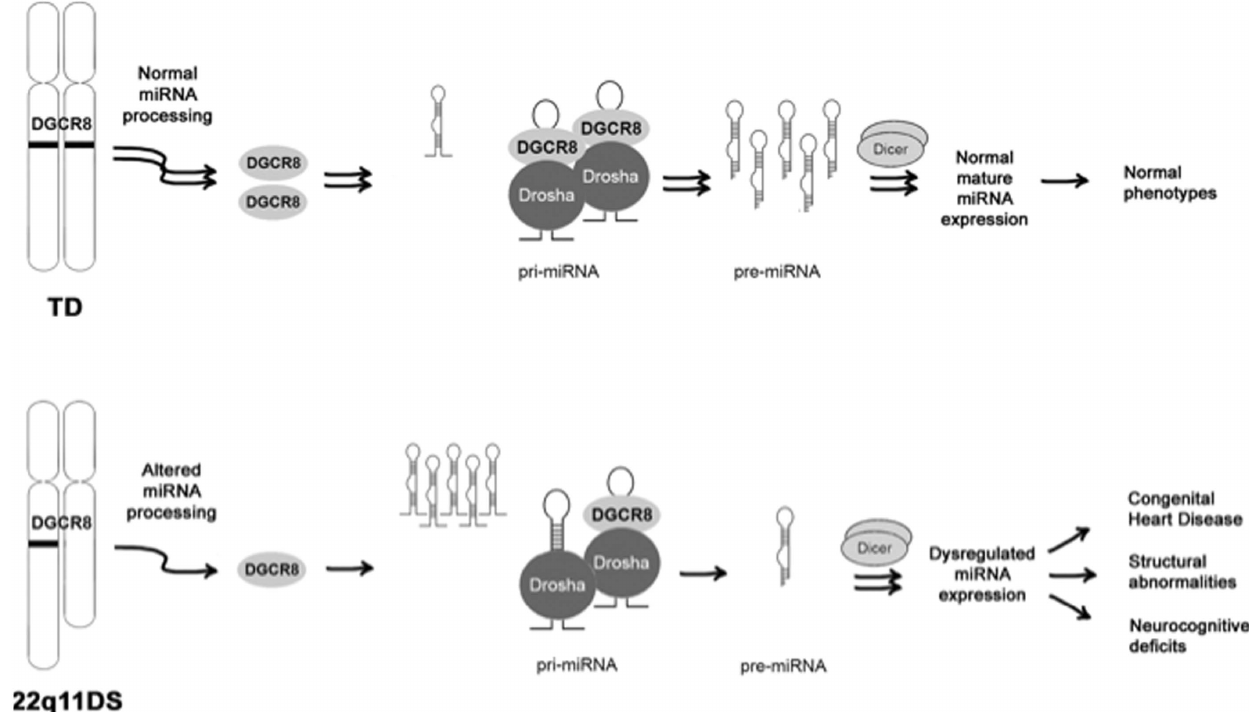
Figure 8. Proposed model of miRNA dysregulation in 22q11DS. Decreased levels of free DGCR8 results in dysregulated expression of mature miRNAs, ultimately leading to development of the clinical phenotypes associated with 22q11DS.